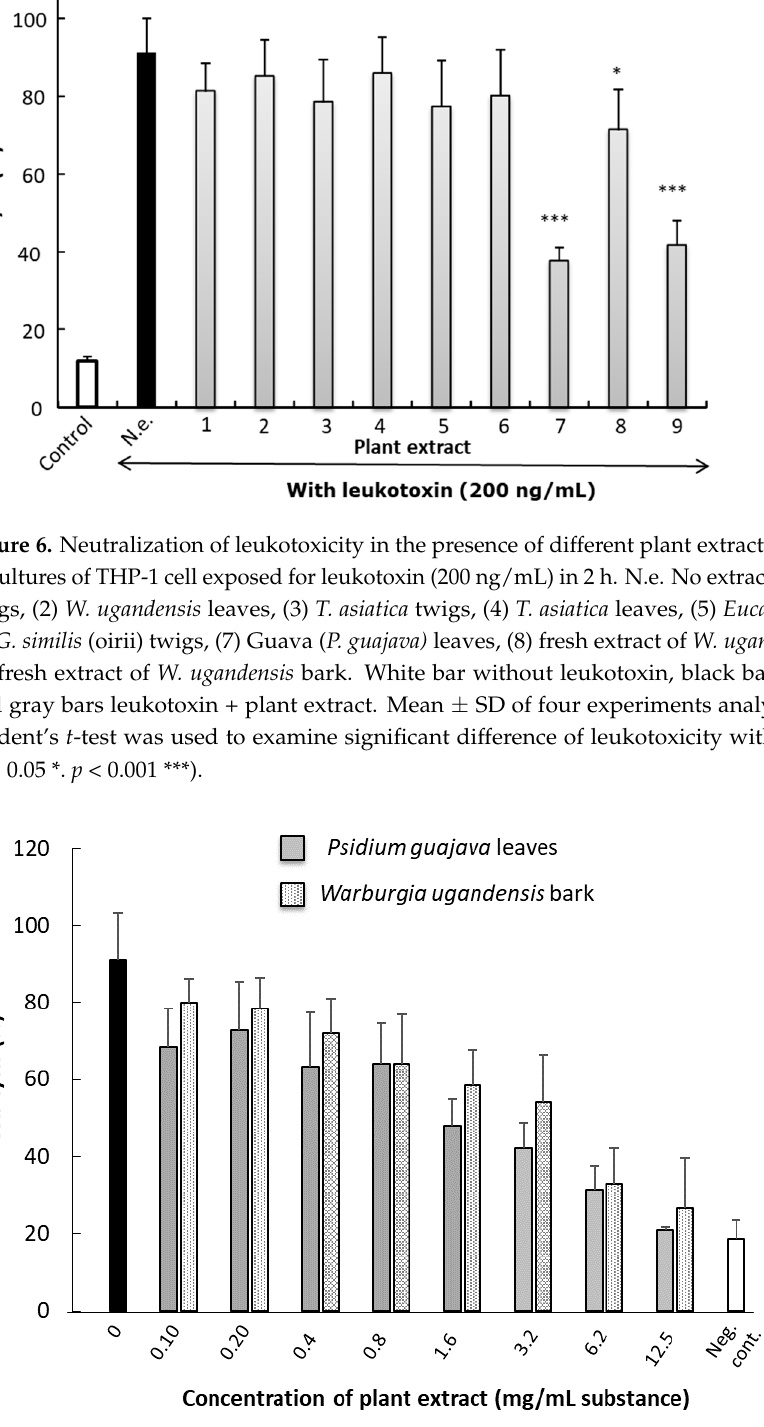
Figure 7. Dose-dependent effect on leukotoxic activity in the presence of extracts from P. guajava leaves or fresh extracts from W. ugandensis bark. Black bar with leukotoxin without plant extract. Mean ± SD of 3–6 observations from two separate experiments. Cultures of THP-1 cells were exposed for leukotoxin (200 ng/mL) for 2 h.